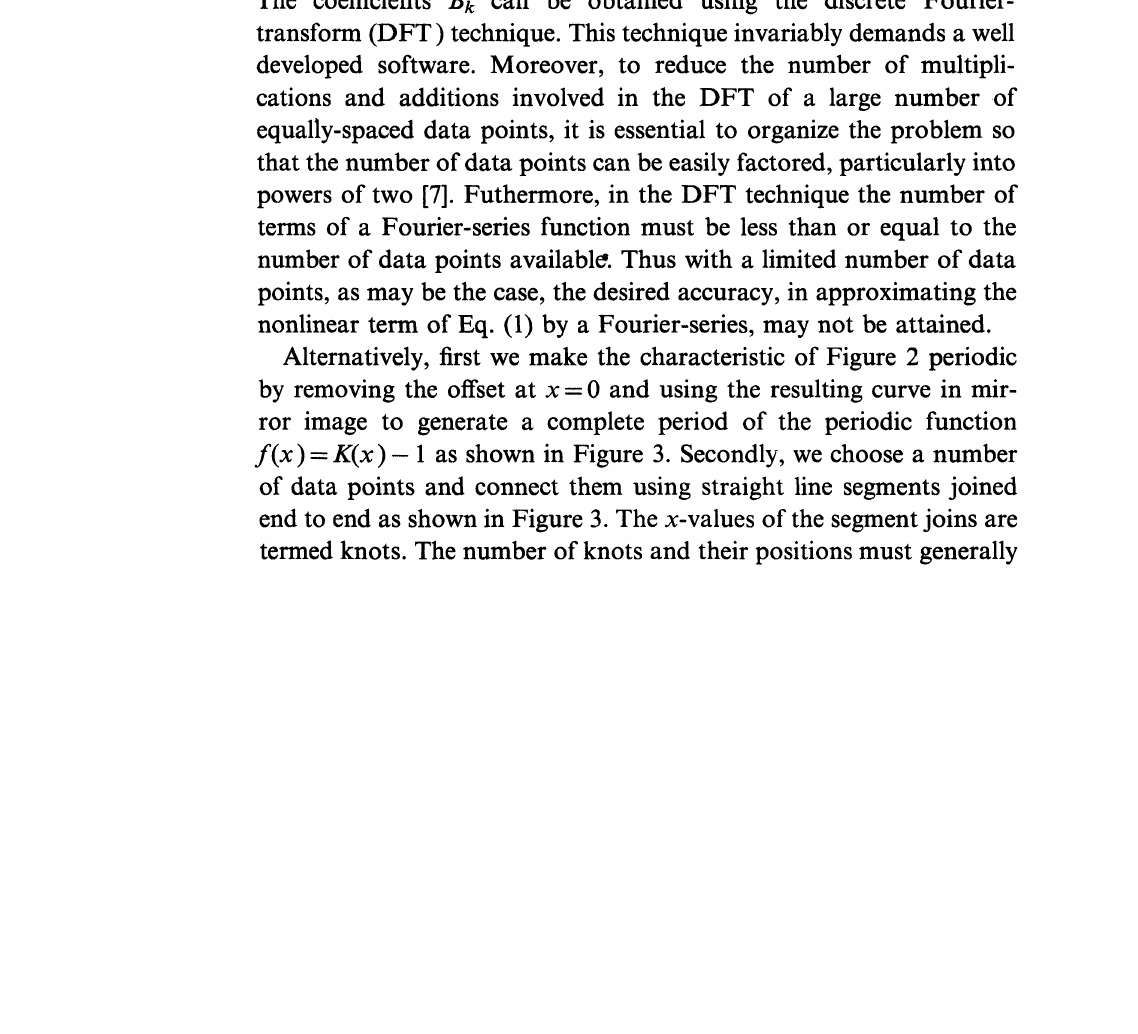
FIGURE 2 Static characteristic of the membrane. Zmax/Zo-" 12.--: Calculated (1), Calculated